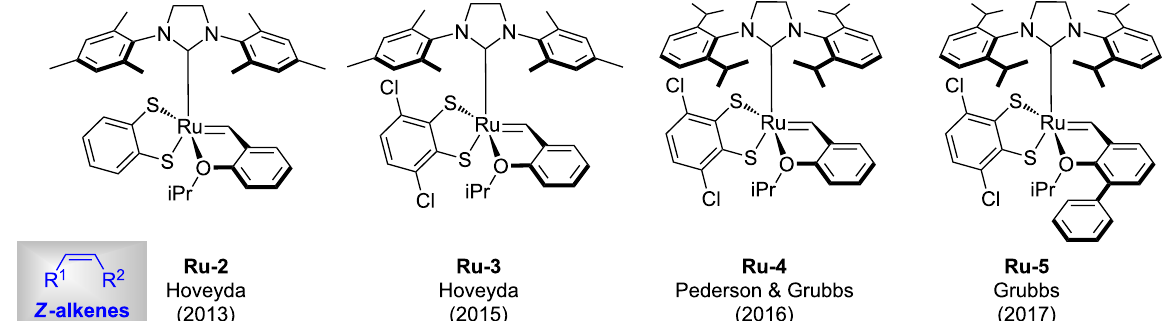
increased catalytic activity for Z-alkenes (Figure 1) [3]. Further improvement was made by the synthesis of Ru-5 bearing